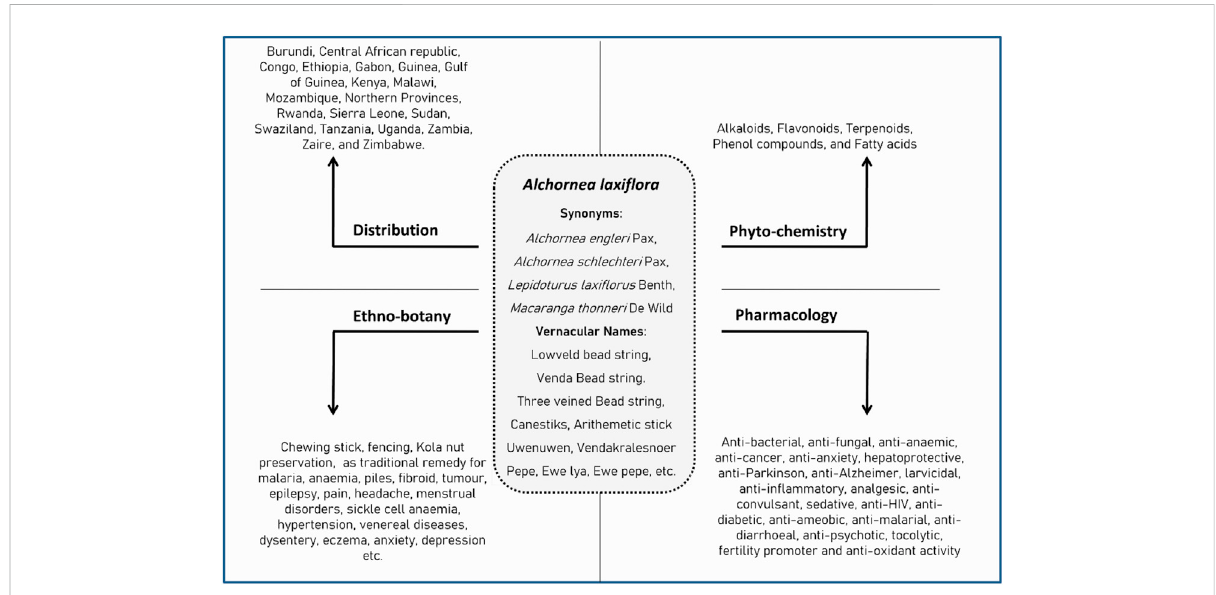
FIGURE 2 Summary of synonyms, geographical distribution, phytochemistry, ethnobotany, and pharmacology of A. laxi fl ora .